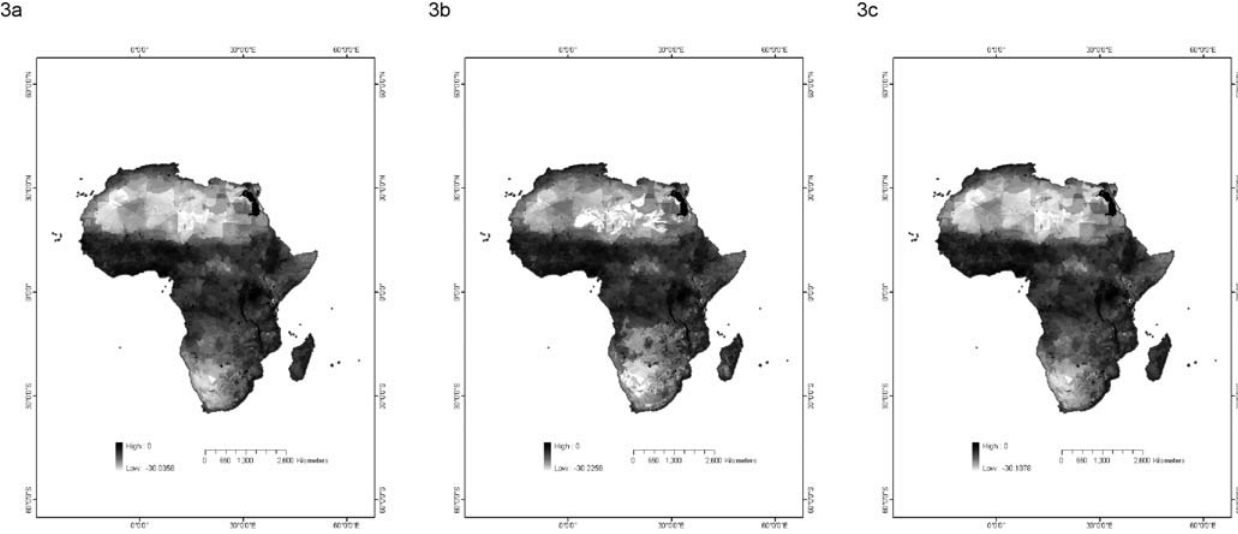
Figure 3. The distribution of malaria relative risk in Africa. Three different types of risk were calculated as follows: (a) the probability of occurrence of each vector in each cell was multiplied by both the human population density of the cell and the HBI of the vector. The relative risk of malaria in the cell was calculated as the sum of these values; (b) the vector possessing the maximum probability of occurrence was identified for each cell. Its probability of occurrence was multiplied by its HBI and the human population density of the cell. The relative risk of malaria in the cell was calculated as the product of these three values; and (c) the probability of occurrence of each vector in each cell was multiplied by the human population density of the cell and the HBI of the vector. The relative risk of malaria in the cell was calculated as the maximum of these values. The maps plot the natural logarithm of the relative risk.